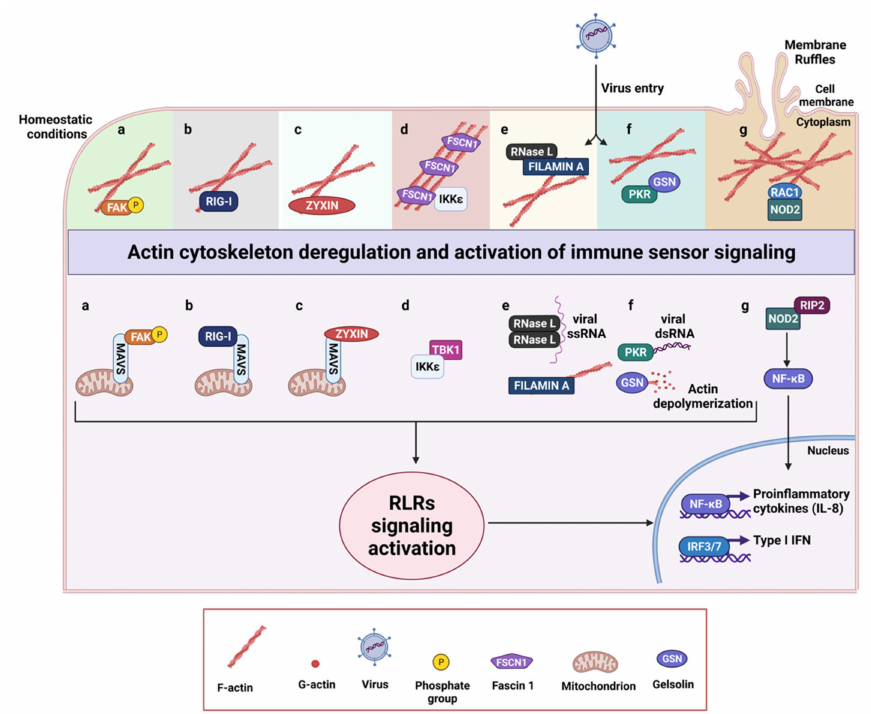
Figure 2. Schematic representation of actin regulatory proteins and their interactions with compo- nents of innate immunity. Under homeostatic conditions multiple innate immune sensors are directly or indirectly linked to the actin cytoskeleton. Deregulation of actin cytoskeleton occurring during tumor progression or following viral infections leads to the activation of RLR signaling activation. ( a ) Focal adhesions kinase (FAK) associates with the actin cytoskeleton in resting cells, but,